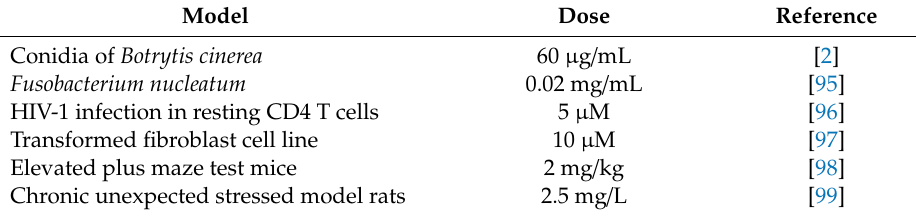
Table 6. Model and dose of antifungal, antiviral and antipsychotic activity of pterostilbene.